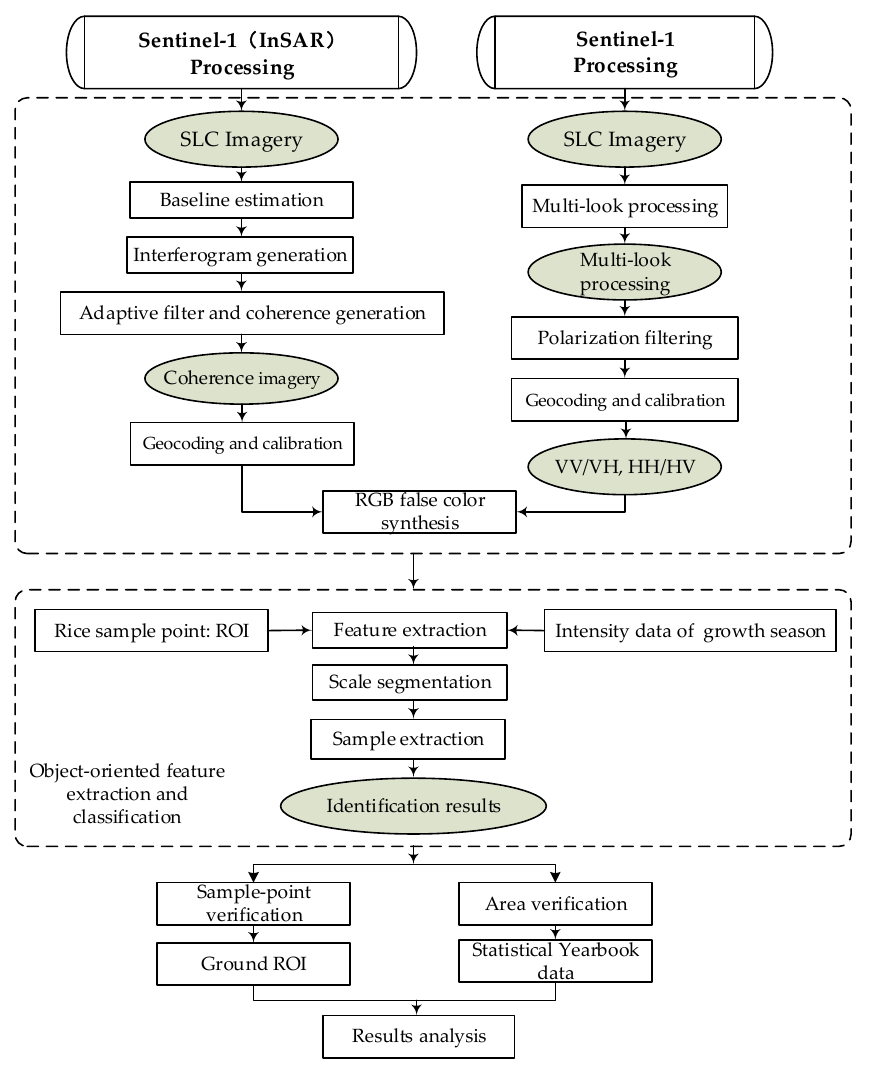
Figure 2. The framework of the study.